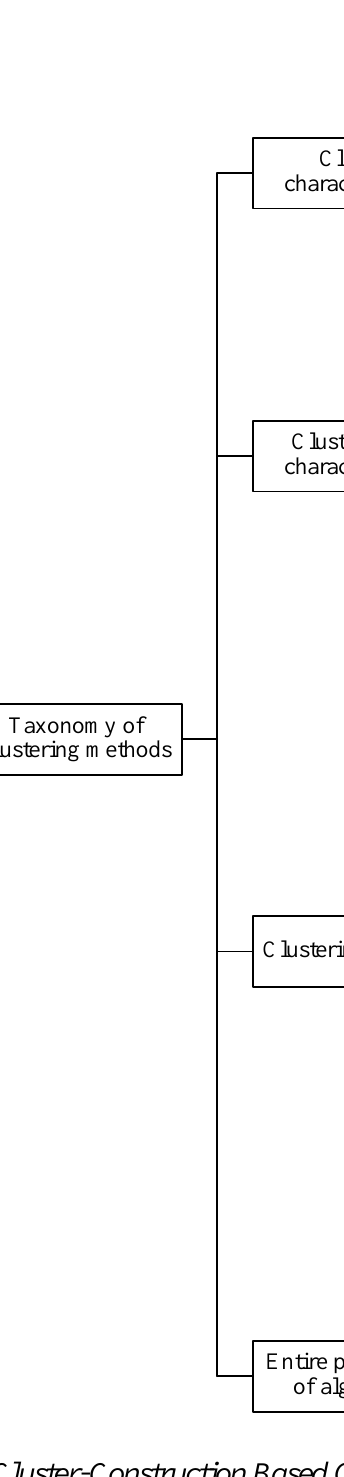
Figure 1. Taxonomy of Clustering Methods in